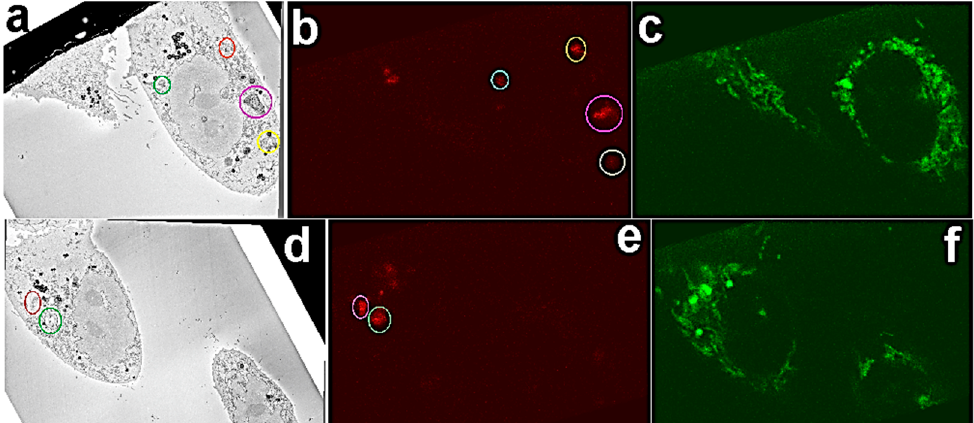
Figure 3. Overview of the corresponding FND aggregates in EM and LM. Corresponding FNDs (color-coded) were matched in respective EM and light microscopy (LM) sections. ( a , d ) SEM images with FND localized in vesicles (color-coded). ( b , e ) Respective FNDs (color-coded) in LM images were matched up. ( c , f ) corresponding MitoTracker